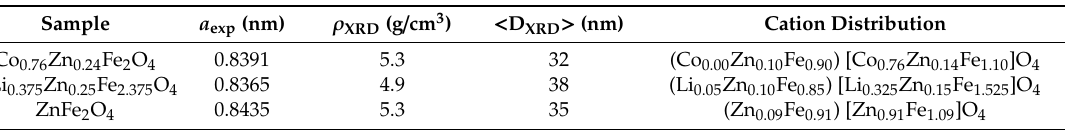
Table 1. Experimental lattice parameters (a exp ); X-ray density ( ρ XRD ); grain mean diameter < D XRD > and cation distribution.